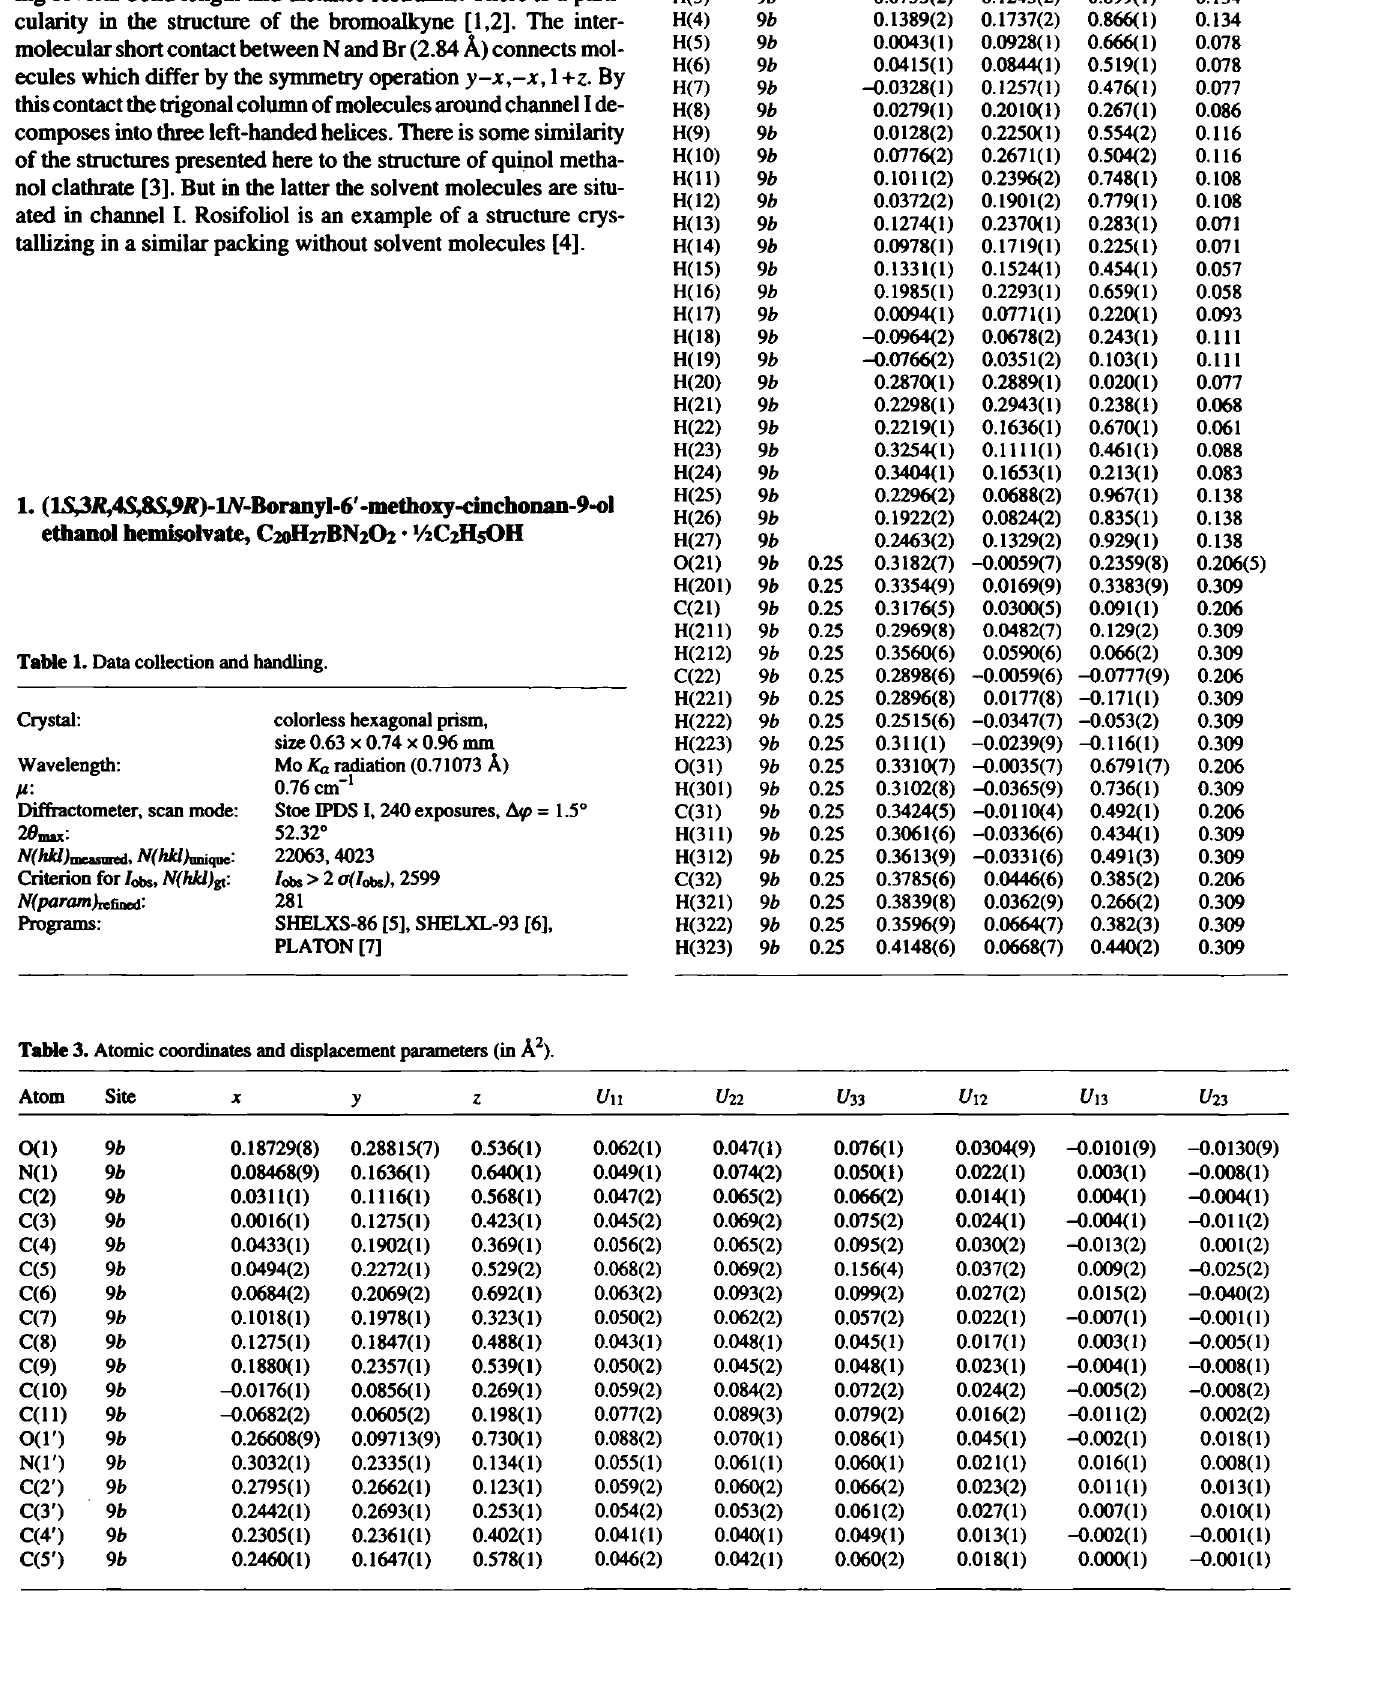
Table 3. Atomic coordinates and displacement parameters (in A 2